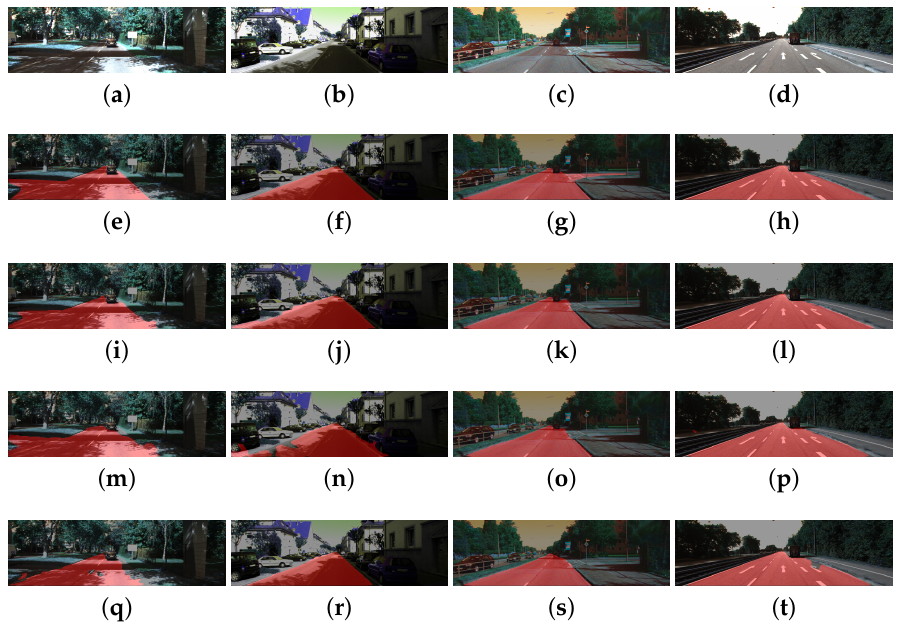
Figure 16. Comparison of various semantic segmentation outputs of trained deep learning ar- chitectures with the original and ground truth images. The above outputs are obtained for four different original test images belonging to the KITTI dataset. ( a – d ) Test images, ( e – h ) ground truth,